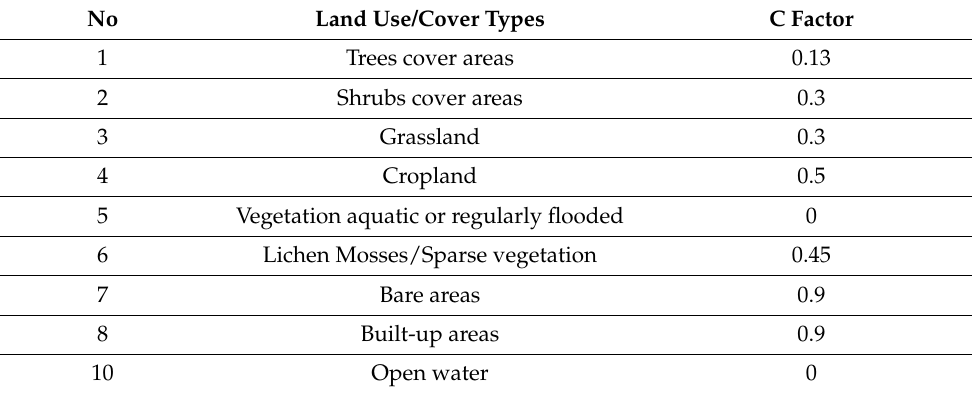
Table 11. C cover factors for Soil Erosion